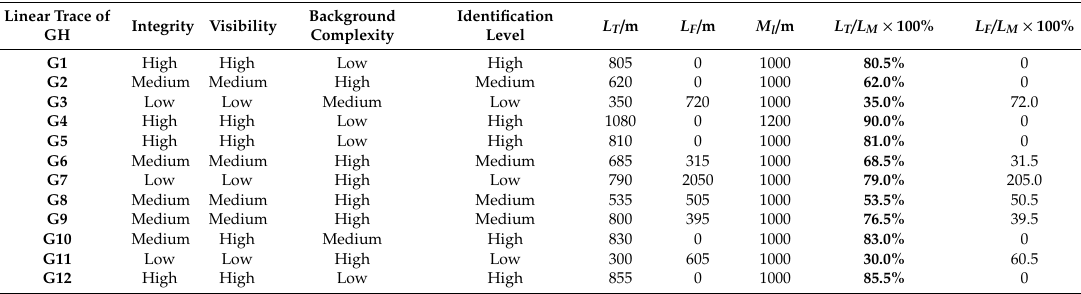
Table 6. Specific characteristics of the 12 typical linear traces of the GH and the results obtained using the proposed identification method.